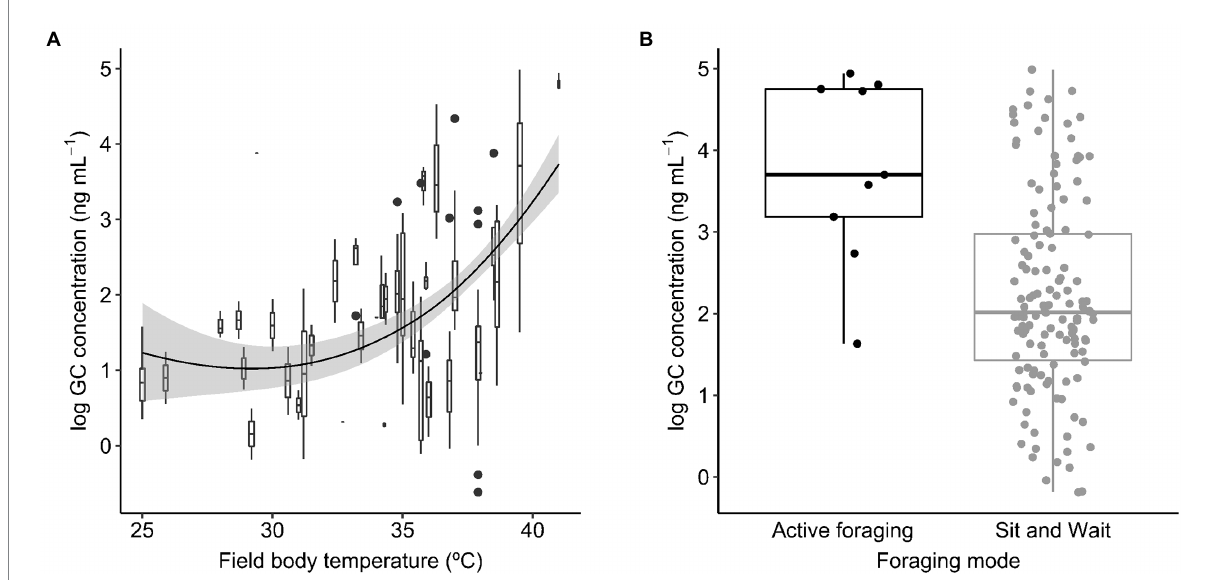
FIGURE 1 Baseline glucocorticoid (GC) concentrations in relation to field body temperature (A) and foraging mode (B) across lizard species. Boxes and whiskers in (A) represent GC levels for each species where horizontal lines within boxes are median GC concentration, boxes capture the interquartile range, and whiskers represent scores outside the lower an upper quartile. The smooth line was generated using loess curve with span parameter of